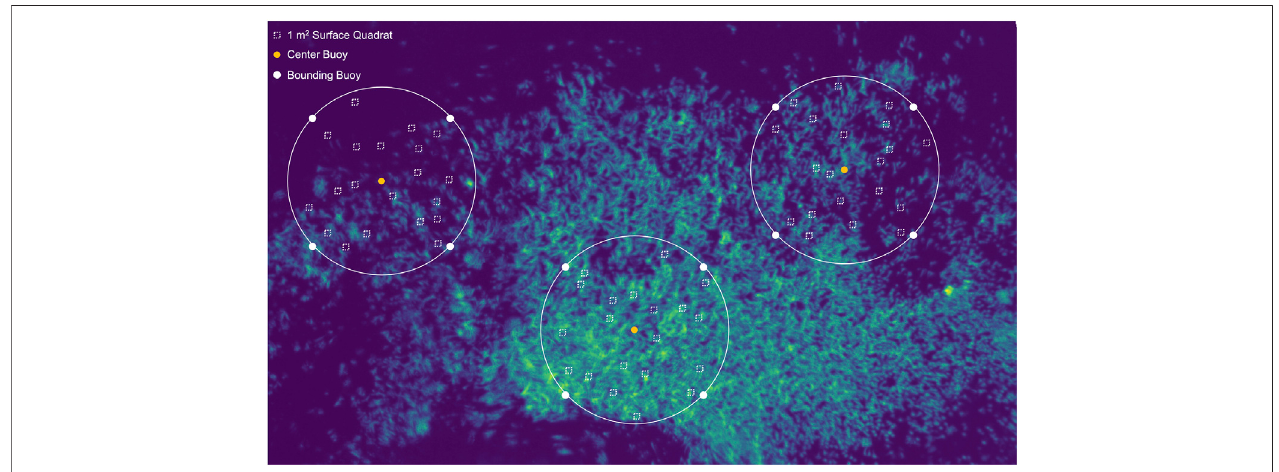
FIGURE 10 | Suggested survey design for future in situ validation studies of canopy biomass using a UAV